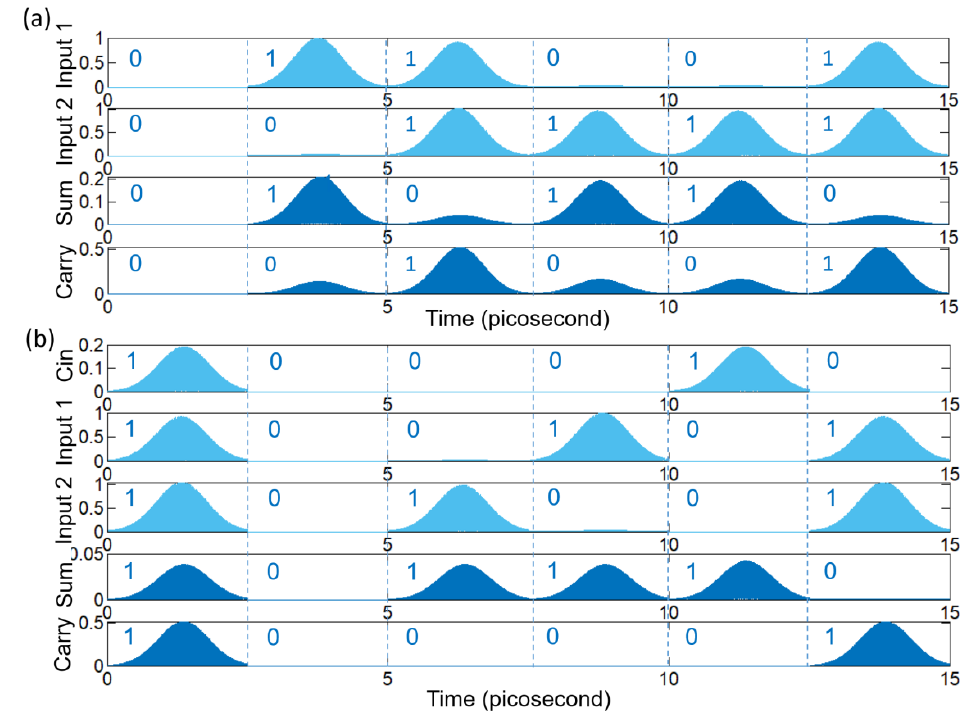
Figure 9. The performance of the half adder and full adder. ( a ) Input pulse and output intensity of half adder; ( b ) Input pulse and output intensity of full adder. Table 3. Logic truth table of the half adder.